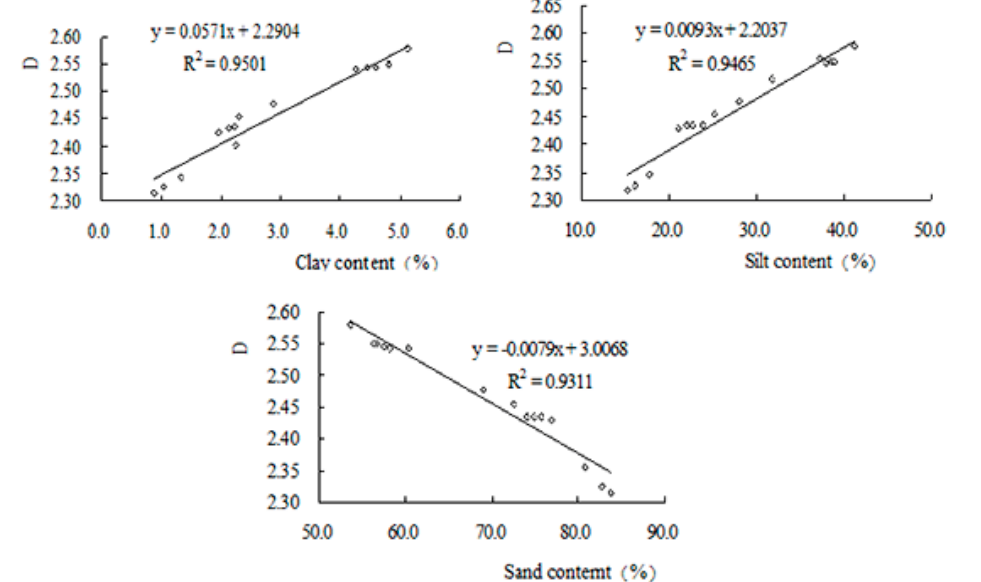
Figure 2. Relationships between D and the percentage of different soil PSD. D —Monofractal dimension of the soil PSD; PSD—Particle size distribution.